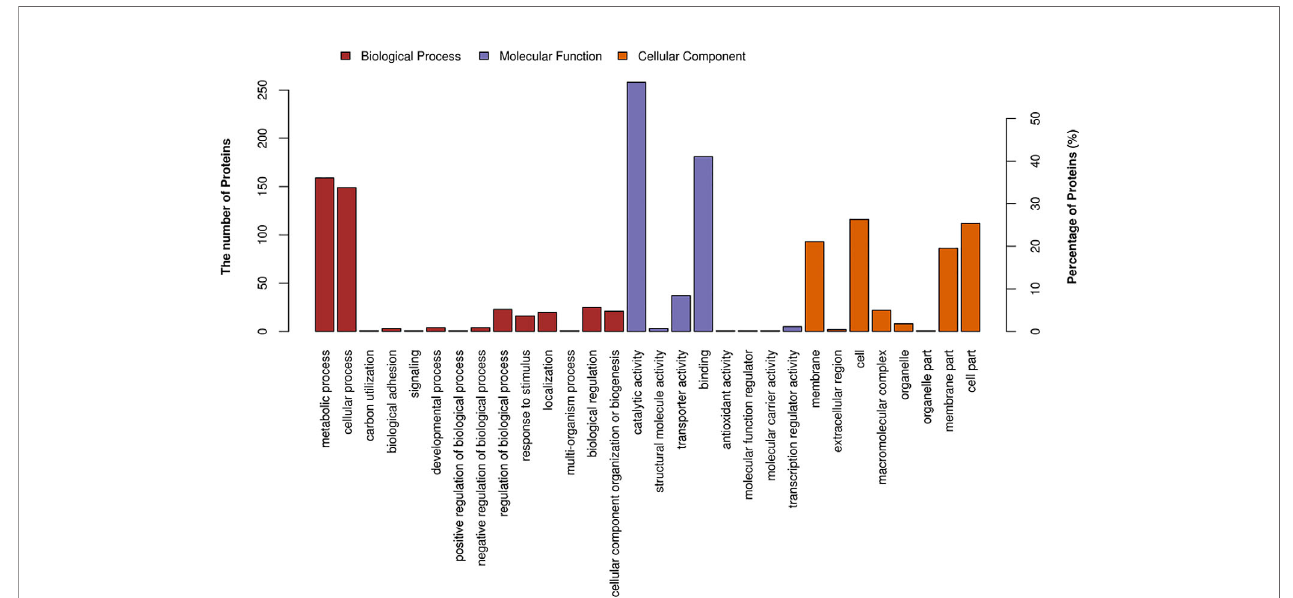
FIGURE 1 | Classi fi cation of differentially expressed proteins in D gidA D mnmE according to gene ontology (GO) annotation on three ontologies (biological process, molecular function, and cellular component).